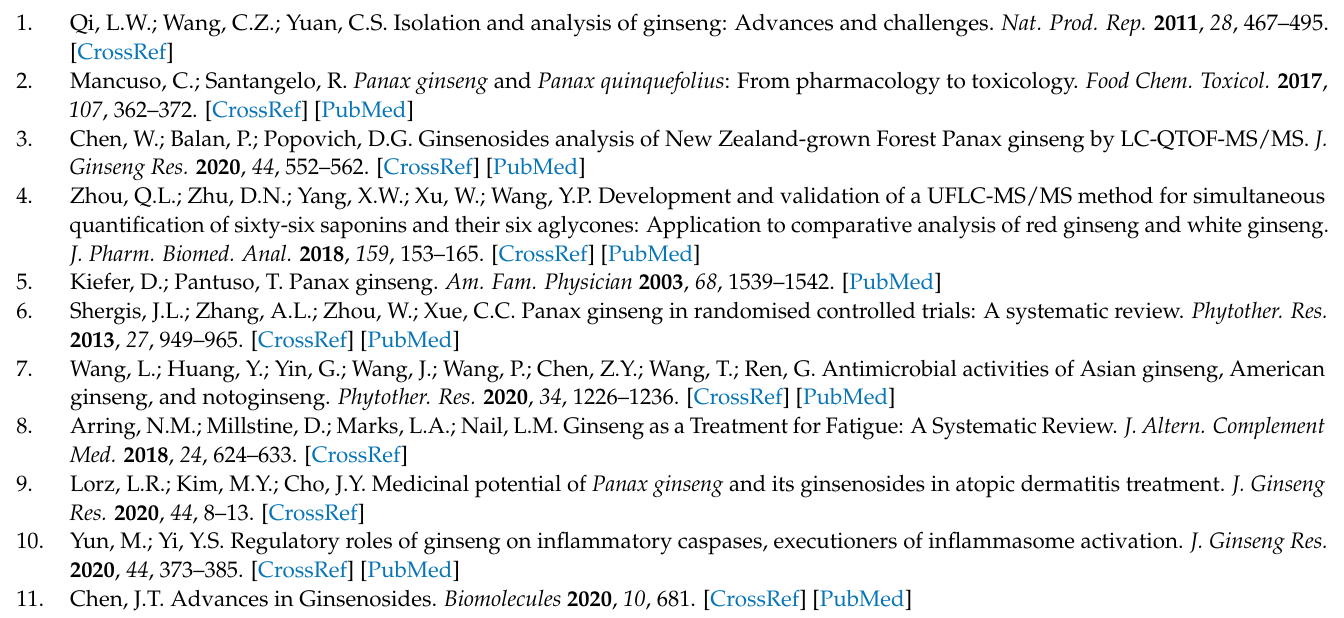
Table S5: Structure of the 63 ginsenoside